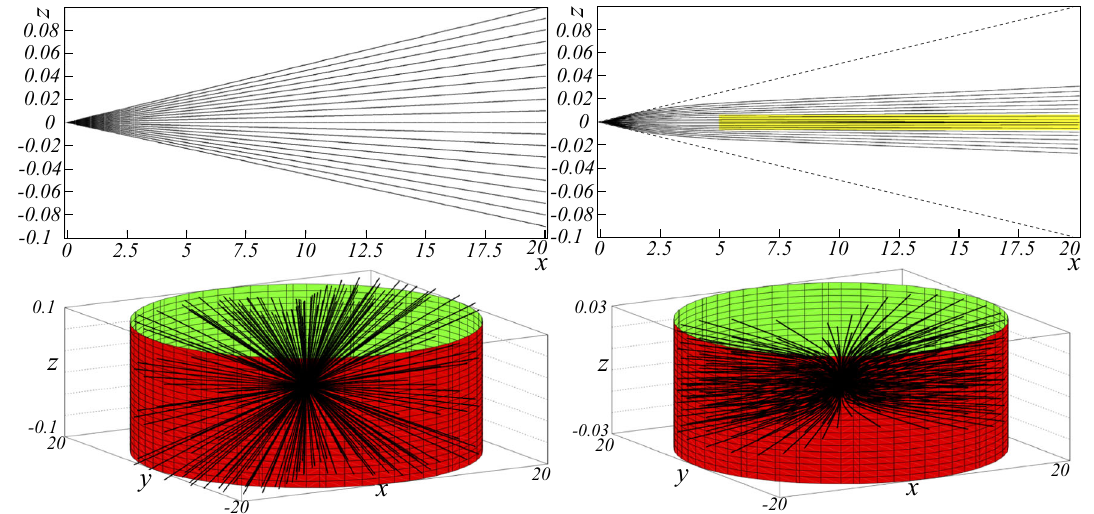
Fig. 3 Field lines for a disk centered at x = y = z = 0, symmetric about z , and of density decreasing exponentially with radius r . Left: without field self-interaction. Right: with self-interaction. For clarity, only field lines emerging with | φ | < 0 . 005 ◦ from the center of the disk are drawn, and the vertical scale on the bottom right panel is zoomed in. Since densities typical of galaxies cause a small bending, larger densities were used here to make the effect clearly visible. The figure